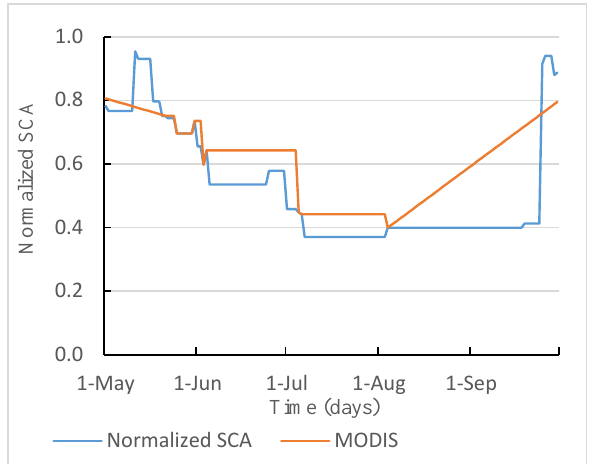
Figure 4. Comparison of normalized SCA obtained from MODIS MOD10A1 and SCA curve from all sources for 2018 Fig. 5 represents individual SDC for six snowmelt seasons and average SDC obtained by estimating average values of